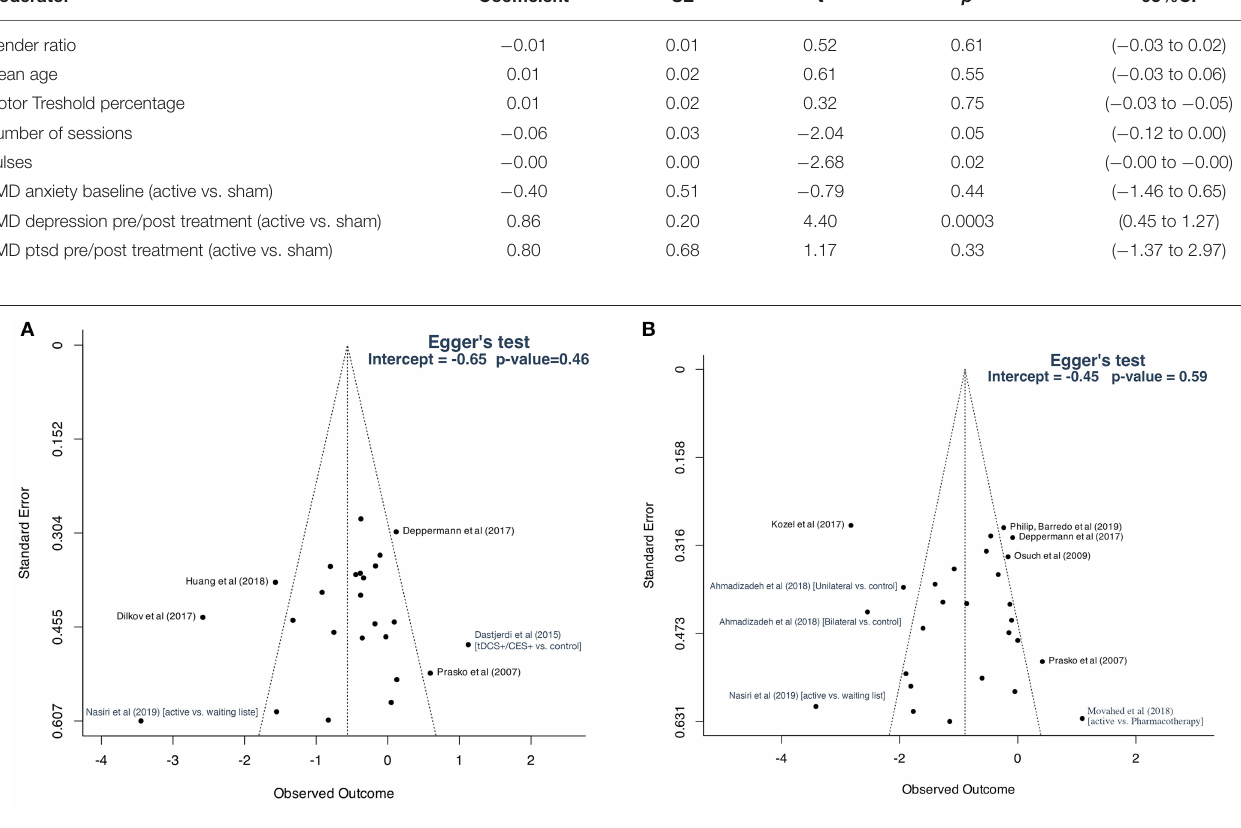
factors, including stimulation parameters (duration, intensity etc.), variability in subjects’ intrinsic cortical excitability, and ongoing pharmacological treatments (74). Thus, the “excitatory” or “inhibitory” classification should be interpreted with